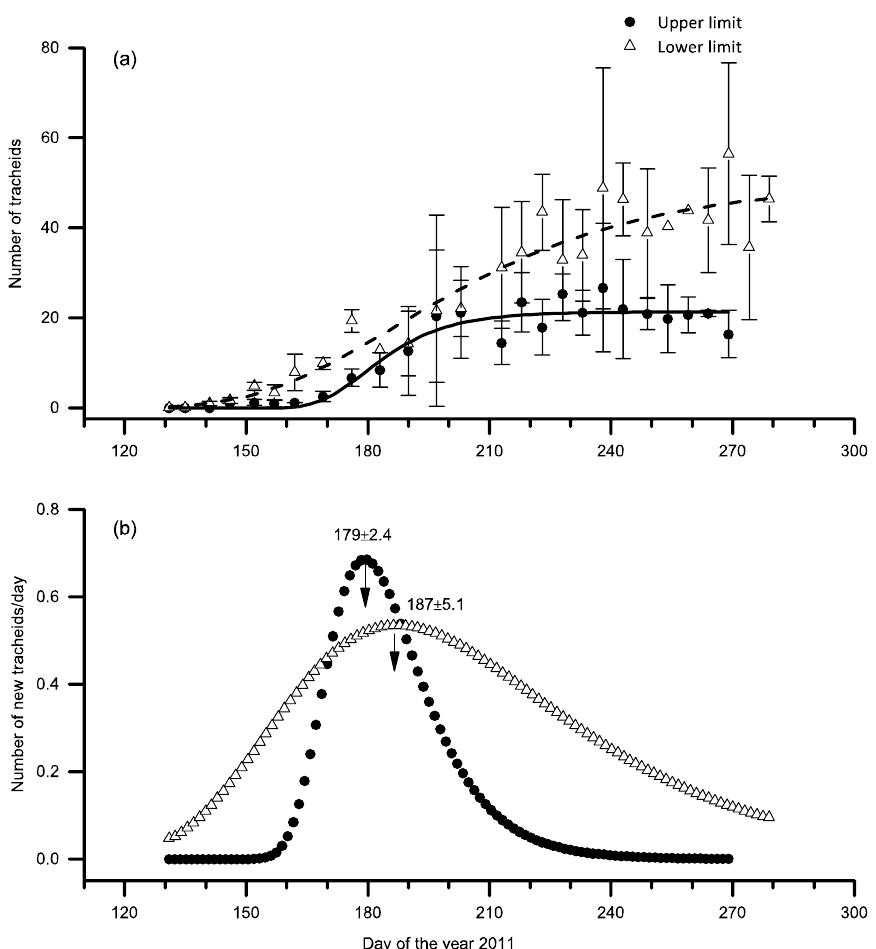
Figure 6. ( a ) Dynamic of xylem growth (including enlarging, wall thickening, and mature cells) are modeled by applying the Gompertz function. ( b ) Daily xylem growth rates are calculated on the basis of modeled growth. Inflection points (day of the year ± standard deviation) are